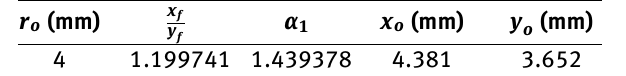
are listed in Table 3.